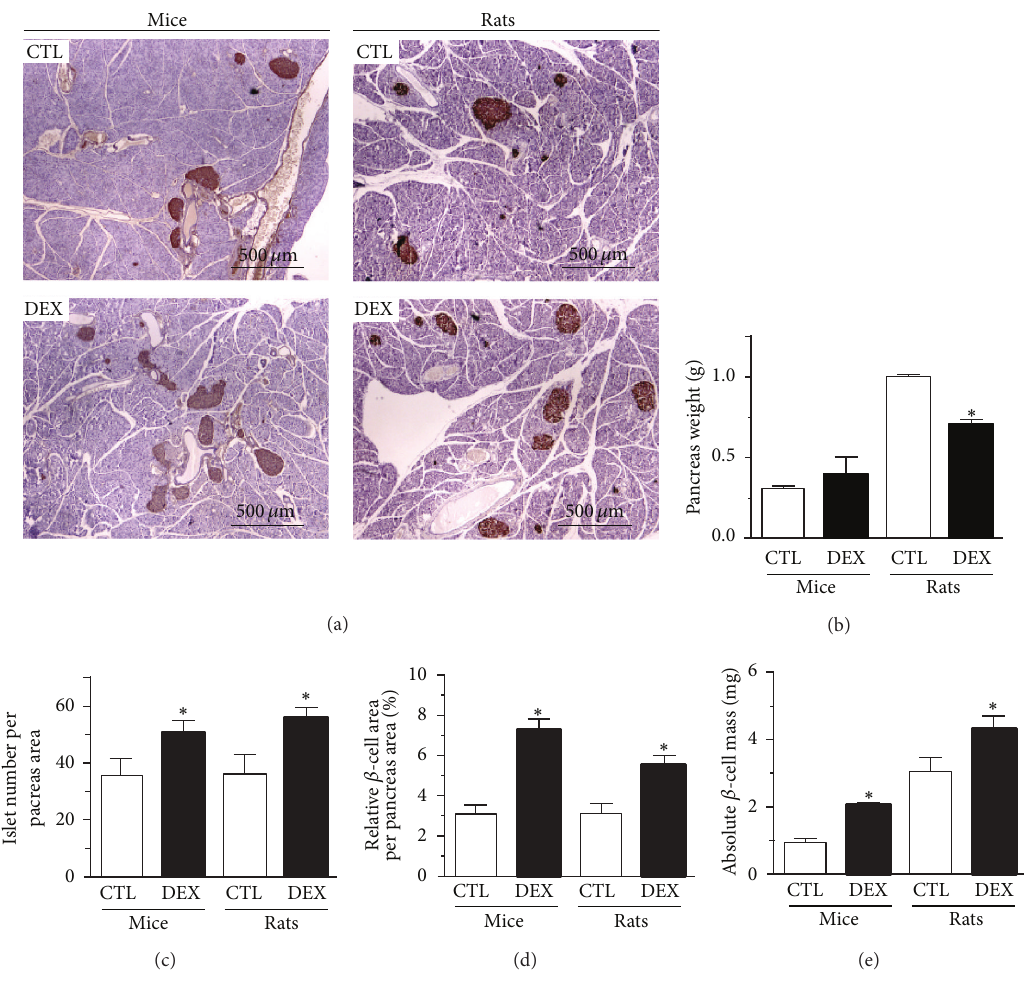
Figure 3: DEX treatment increases 𝛽 -cell mass in the pancreas of mice and rats. (a) Representative pancreas sections stained for insulin with Hematoxylin counterstaining. (b) Pancreas weight, (c) relative islet number per pancreas area, (d) relative 𝛽 -cell area per pancreas area, and (e) absolute 𝛽 -cell mass in DEX-treated mice and rats. Values are mean ± S.E.M.; 𝑛 = 5-6 animals per group ( ≈ 150 islets from mice and ≈ 300 islets from rats). ∗ Significantly different compared to CTL. Unpaired Student’s 𝑡 -test, 𝑃 ≤ 0.05